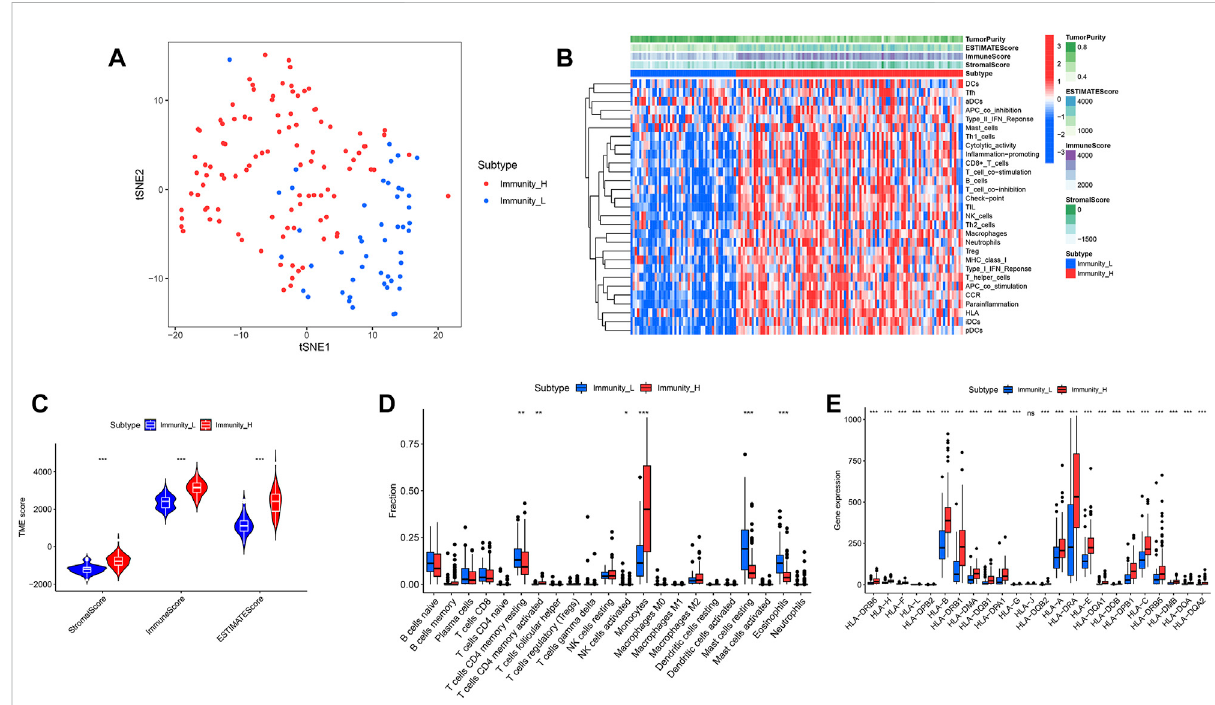
FIGURE 2 “ hclust ” clustermethodandimmune-relatedfunctions. (A) t-SNEwasusedtotesttheclusteringresultsofthehighandlowimmunegroups. (B) Heatmaps of immune-related pathways in the high and low immune groups. (C) Stromal score, immune score and total score in the high and low immune groups. (D) Comparison of 22 kinds of immune cells in the high and low immune groups. (E) Comparison of human leukocyte antigen differences between high and low immune